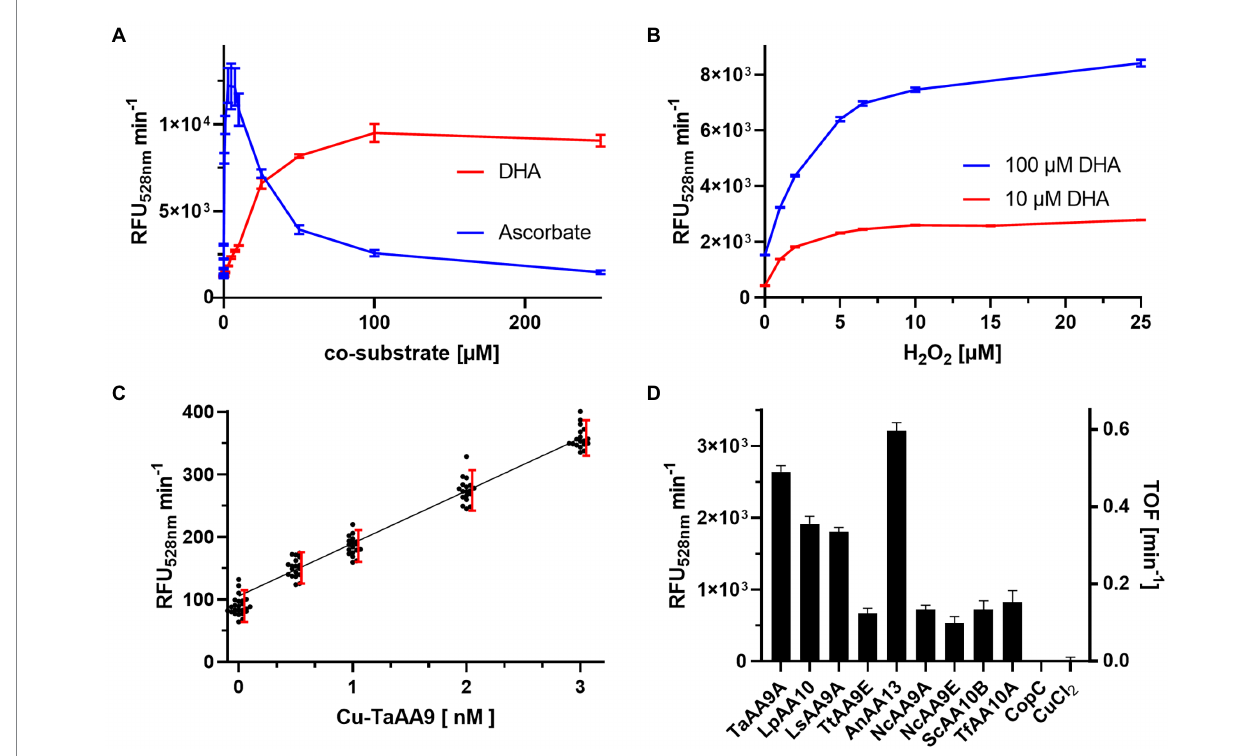
FIGURE 3 Dose response of the rFl assay (A) Initial rates of rFl oxidation by 30 nM Cu(II)- Ta AA9A with 6.35 μ M rFl, 100 μ M H 2 O 2 and 0–250 μ M DHA (red) or ascorbate (blue). (B) Initial rates of rFl oxidation by 30 nM Cu(II)- Ta AA9A with 6.35 μ M rFl, 0–25 μ M H 2 O 2 and 10 (red) or 100 (blue) μ M DHA (See also Supplementary Figure S2). (C) Initial rates of rFl oxidation by 0–3 nM Cu-Ta with 10 μ M DHA, 10 μ M H 2 O 2 and 6.35 μ M rFl. Each enzyme concentration was prepared as 18-fold redundant samples. Red bars demarks the 90% normal distribution range and the black line is a linear fit of data from the range of 0.5–3 nM Cu-Ta. (D) The initial rates of a series of 30 nM Cu(II)-LPMOs with 10 μ M DHA and 10 μ M H 2 O 2